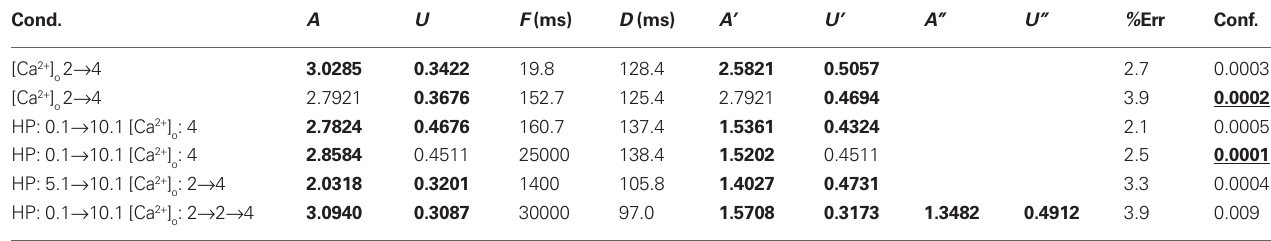
Table 4 | Markram–Tsodyks model best-fit parameters for different conditions.